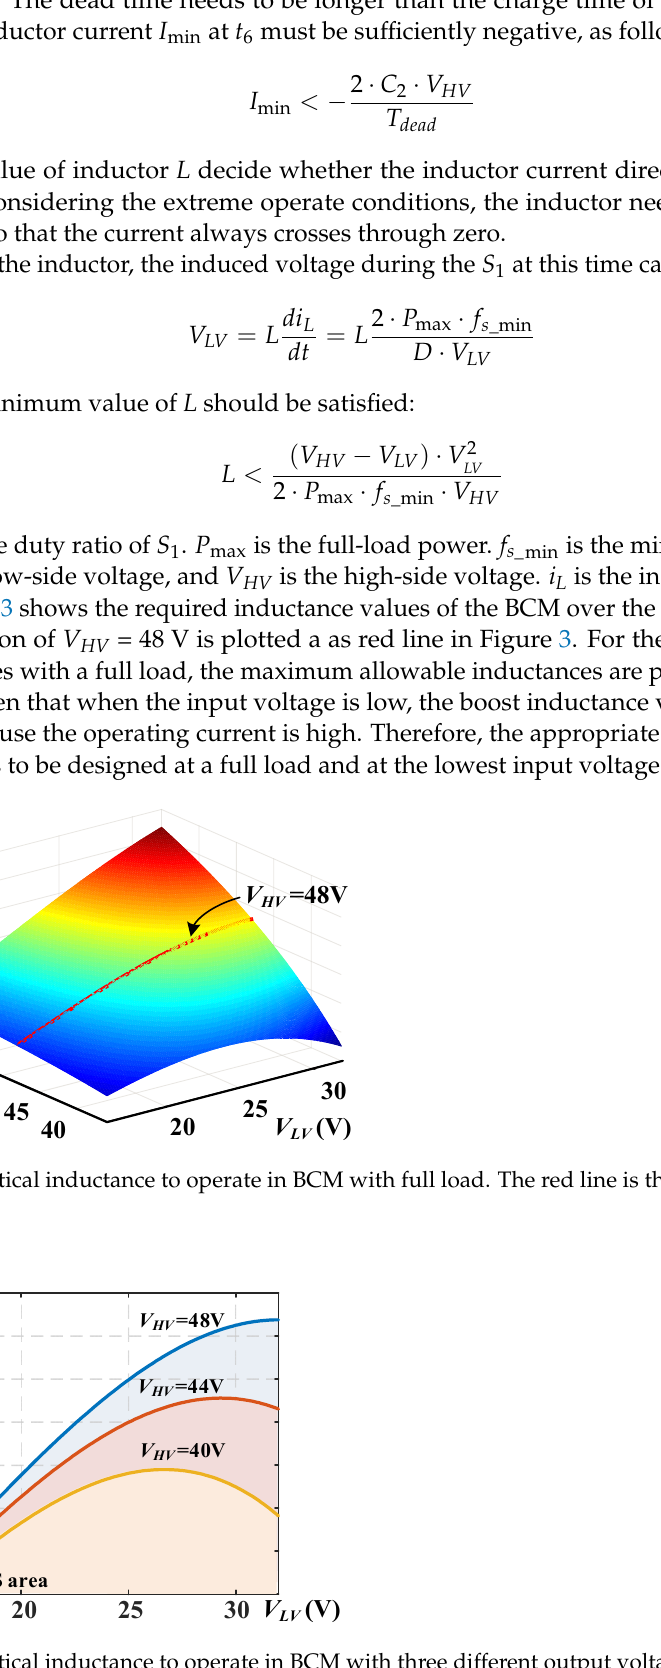
Figure 4. Critical inductance to operate in BCM with three different output voltage cases .